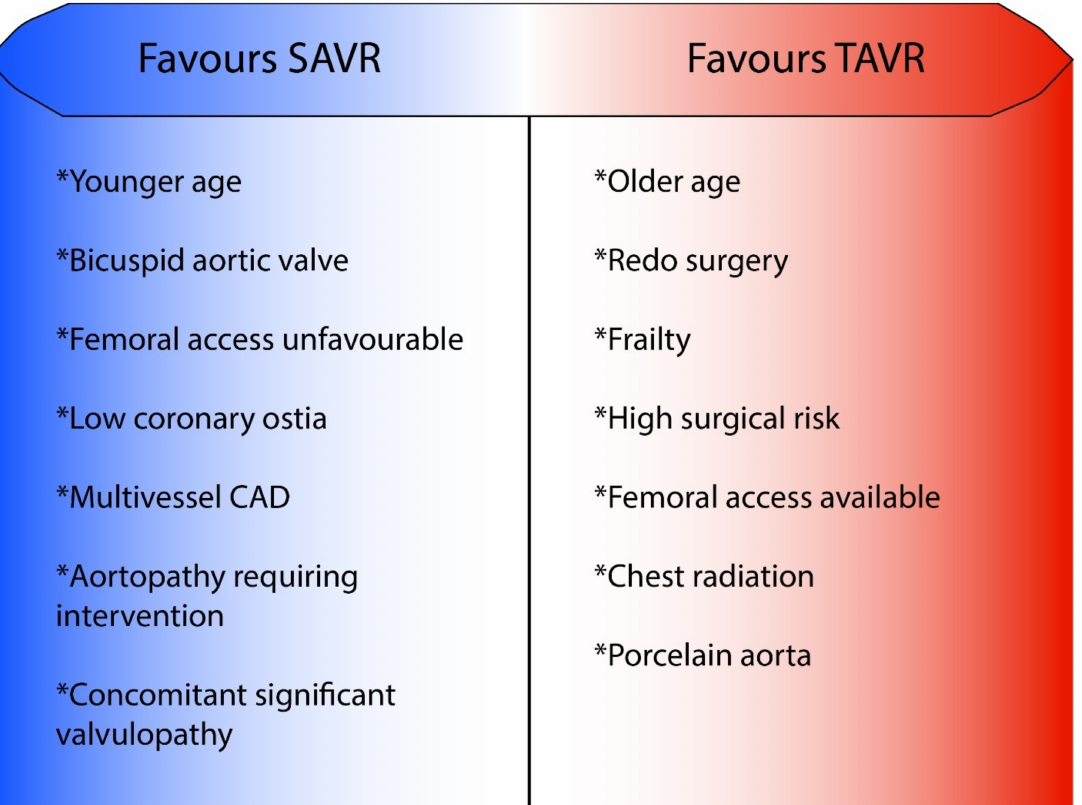
Figure 1. Clinical characteristics in favor of surgical or transcatheter aortic valve replacement. CAD, coronary artery disease; TAVR, transcatheter aortic valve replacement; SAVR, surgical aortic valve